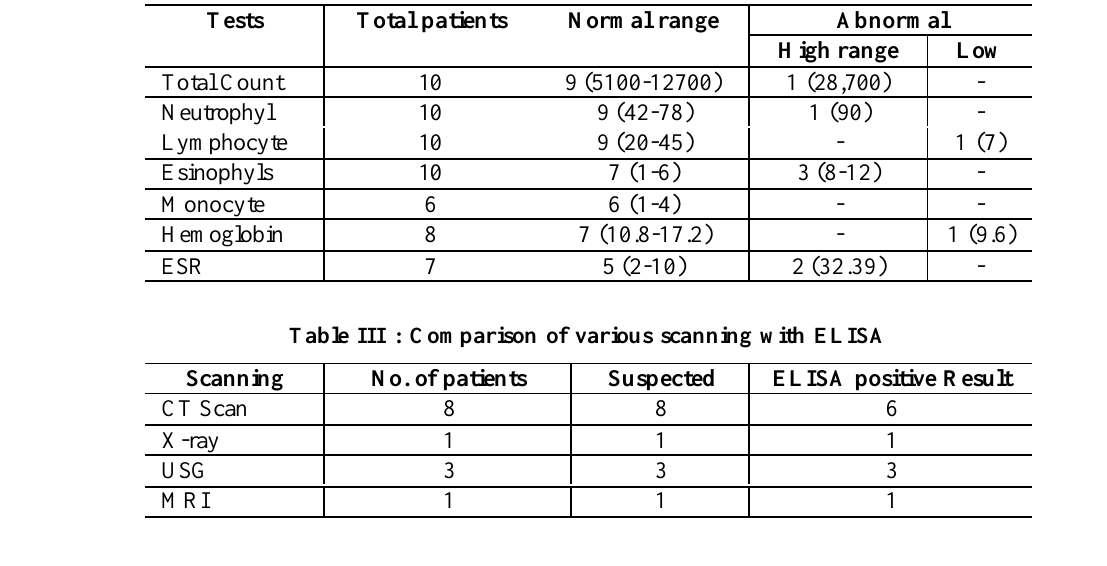
Table IV : Biochemical examination of suspected patients for